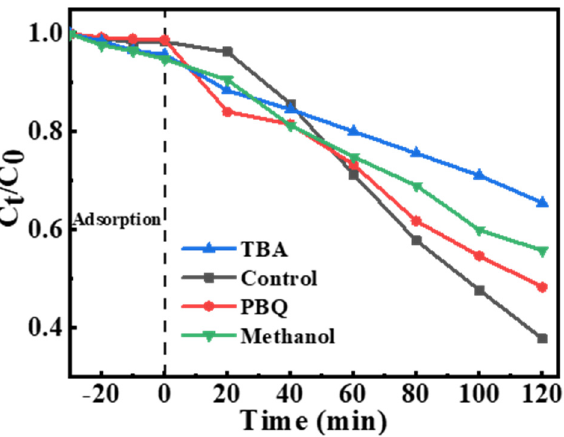
Figure 6. The efficiency of scavengers on the degradation of norfloxacin in Pd/C@CF system (Na 2 S 2 O 8 , 3 mM; norfloxacin, 10 mg/L; TBA, 0.5 M; Methanol, 0.5 M; PBQ, 5 mM; volume of norfloxacin, 100 mL; solution pH, 7.0; applied potential, − 0.8 V vs. Ag/AgCl).